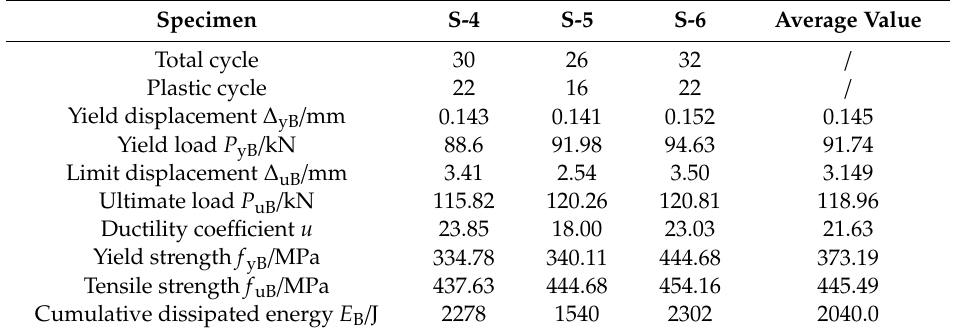
Table 3. Testing results for the jointed